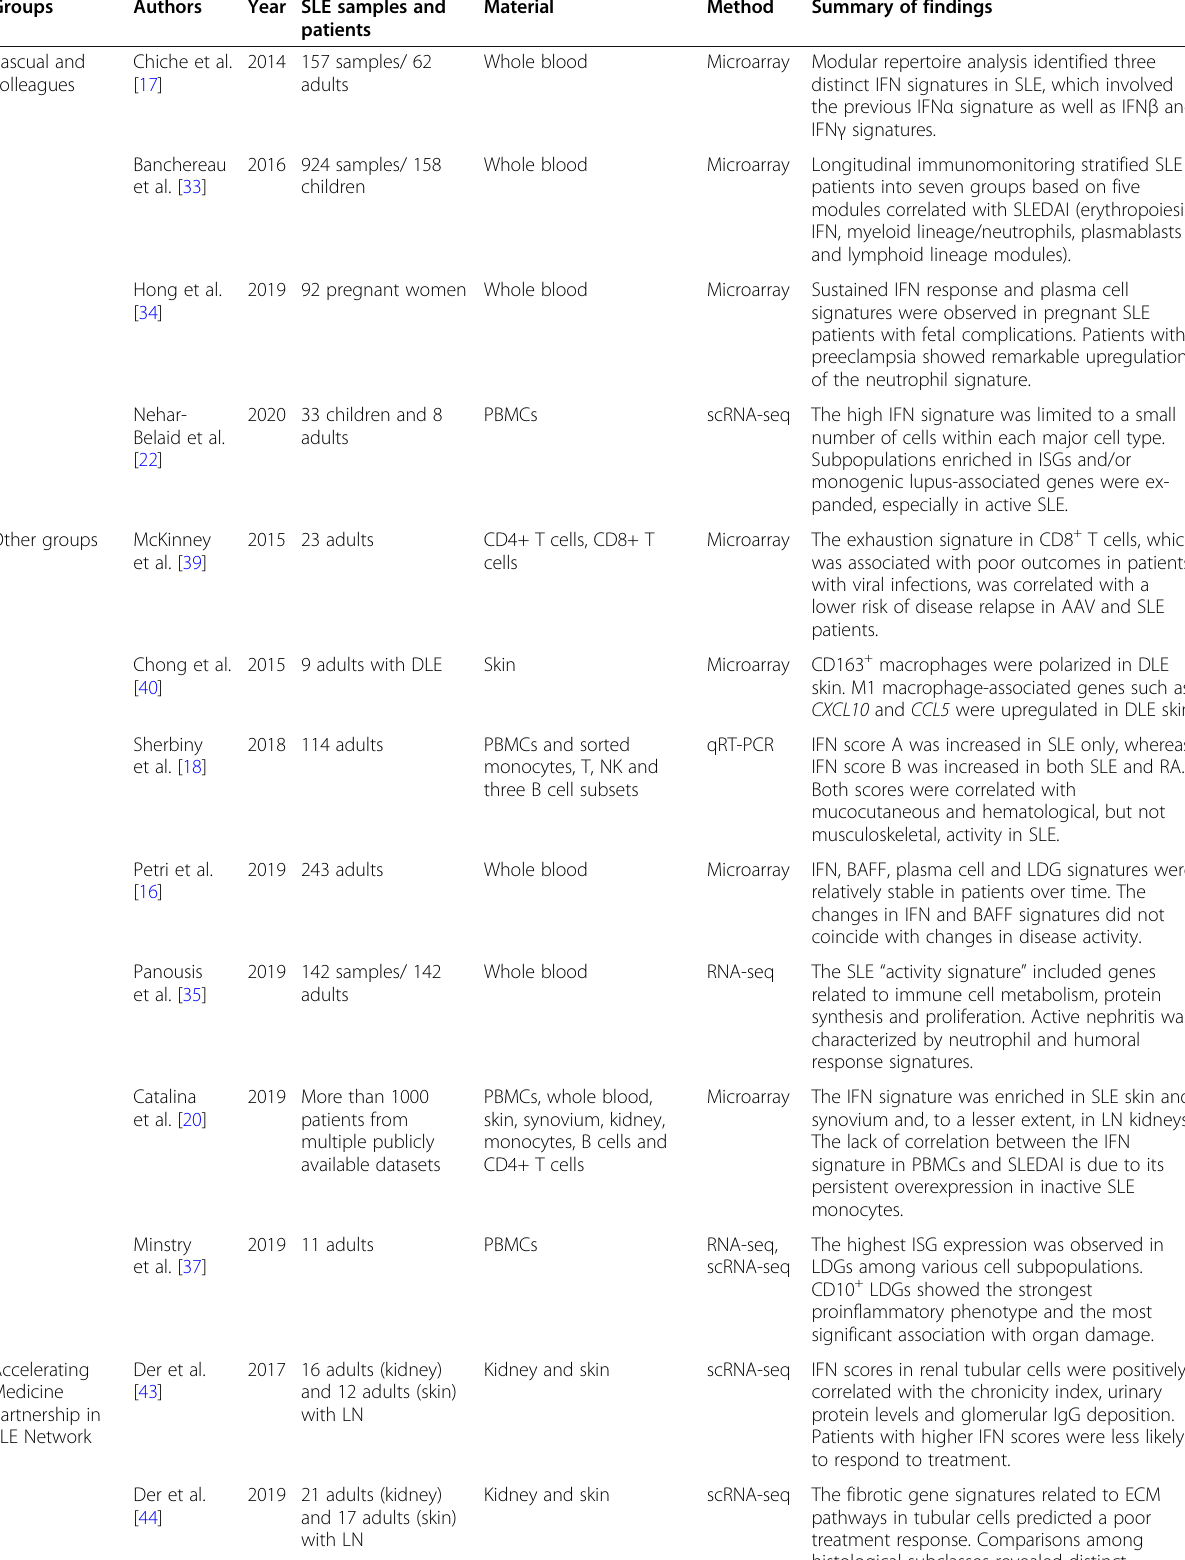
Table 1 Summary of recent transcriptome studies in